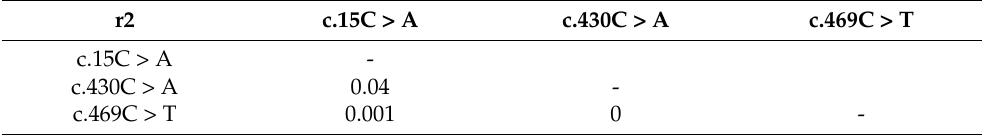
Table 2. Linkage disequilibrium (LD) among genetic polymorphisms in the SPRN gene in cats.